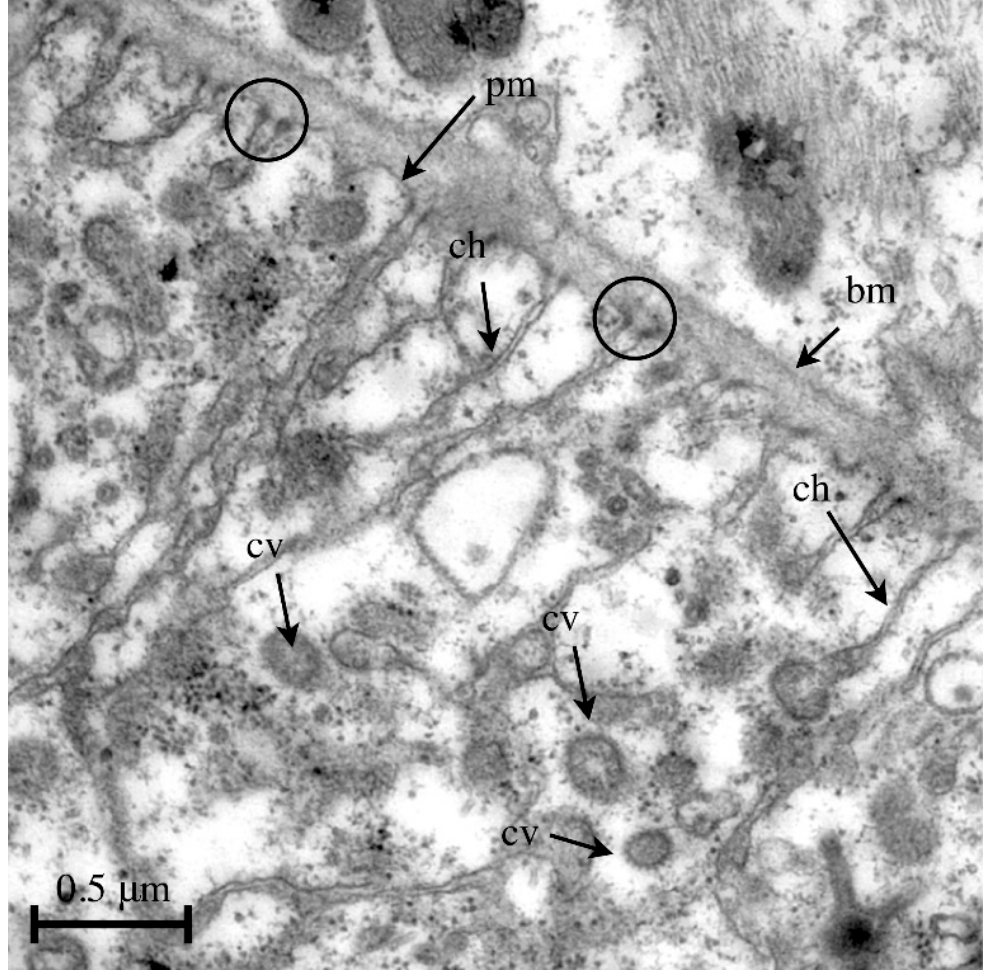
Figure 5. Transmission electron micrograph of the periphery of a pericardial cell isolated from a wild-type third instar larva. The cortex of pericardial cells is characterized by invaginations of the plasma membrane, forming a labyrinth-like channel system with a considerably increased surface area. Endocytosis takes places at the terminal sites of the channel system. Such an event is visible at the labeled channel on the right. Abbreviations: bm, basement membrane; pm, plasma membrane; ch, labyrinth channel; cv, coated vesicle; slit diaphragms are indicated by circles.